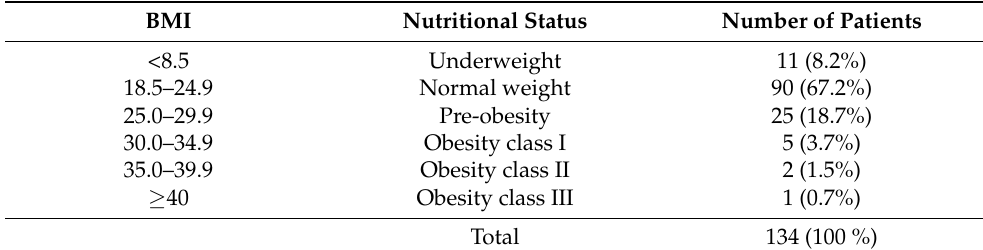
Table 2. BMI classification according to the WHO [24] and number of patients in each group.